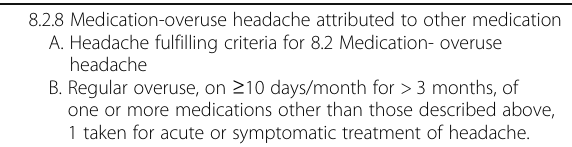
Table 1 International Classification of Headache Disorders Third Edition (ICHD-3) Criteria for Medication-Overuse Headache